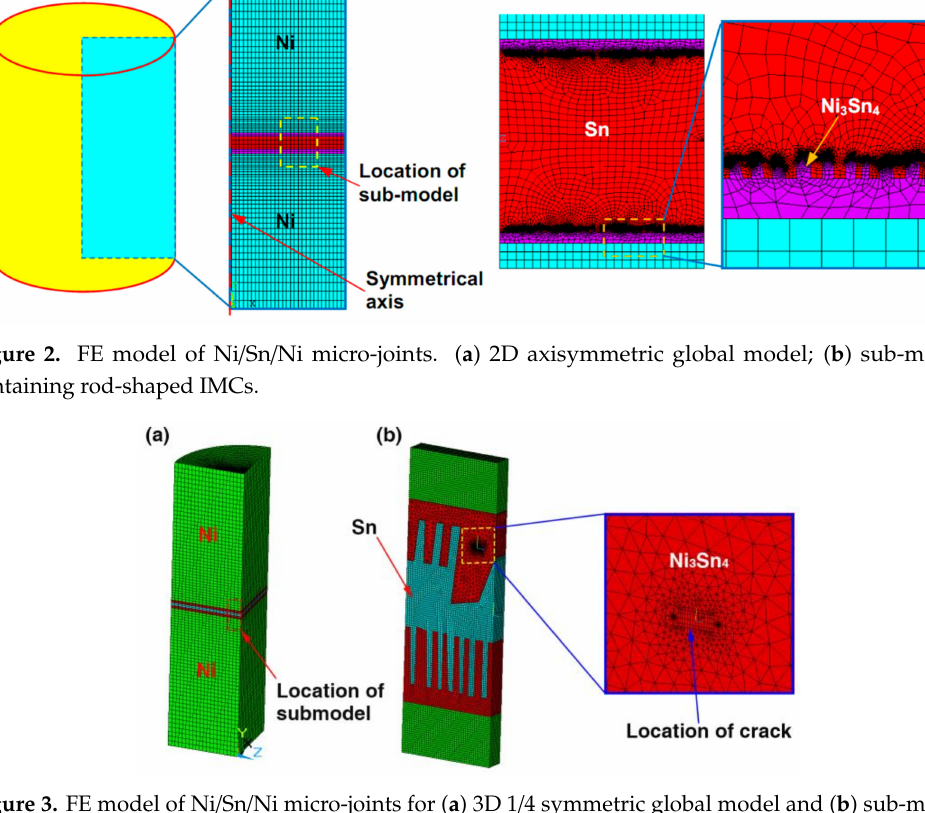
Figure 3. FE model of Ni / Sn / Ni micro-joints for ( a ) 3D 1 / 4 symmetric global model and ( b ) sub-model with a pre-existing crack at the chunky IMC surface. Table 1. Plastic constants for Sn solder.